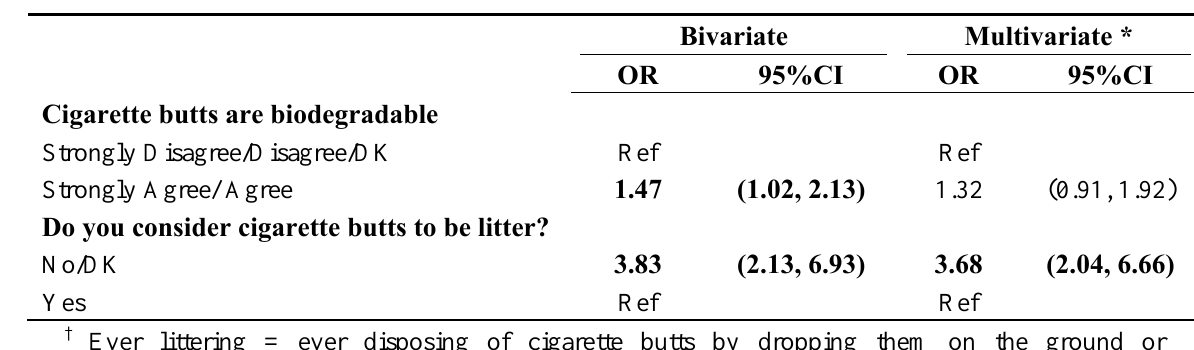
Table 4. Statistically significant predictors of ever littering † cigarette butts among smokers (n =